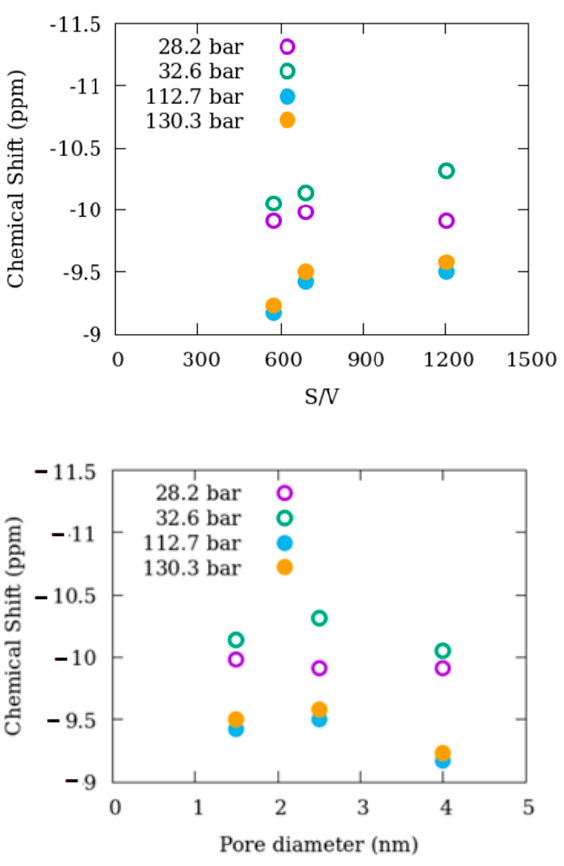
Figure 3. Change in the isotropic chemical shift in 13 C NMR positions of methane in mixtures with engineered nanoporous silica proxies. The open circles represent bulk-like methane, while the filled circles represent confined methane. 307 K for P = 28.2 and 112.7; 346 K for P = 32.6 and 130.3 bar. Data on 4 nm silica-methane are from Ok et al. [15]. The unit of S/V is 1/m.